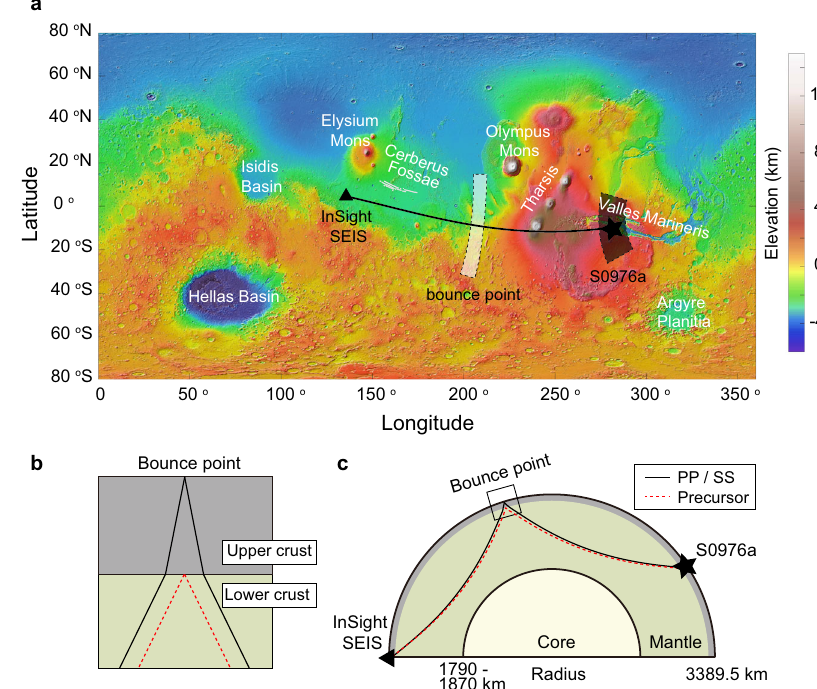
Fig.1|Locationsofthemarsquake,seismicstation,andbouncepoint.a Global topographic map from the Mars Orbiter Laser Altimeter (MOLA 33 ). The triangle marks the location of the InSight landing site, the star shows one of the possible locationsof the marsquake(seeMethods section),and the raypath is in black.The uncertainty of the marsquake location from seismological constraints is indicated by the shaded area (in black). The shaded region (in white) between the event and the station marks the possible corresponding locations of the bounce